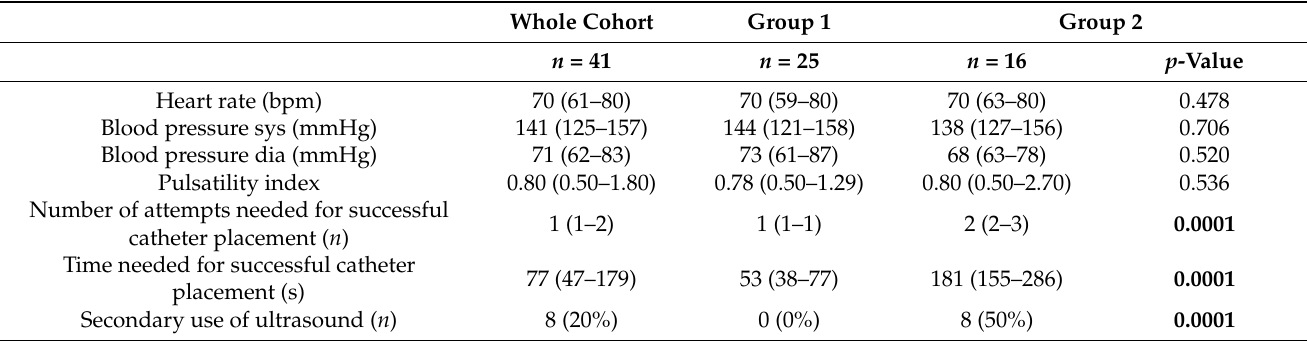
Figure 2. Radial artery catheterization. Time needed for successful radial artery (RA) catheterization with lower body weight, height and surface area as well as with smaller distal (at the level of the styloid process) and 5 cm proximal internal RA diameter. Spearman correlation was used for analysis. Table 2. Results of radial artery cannulation observations in the whole cohort as well as in group 1 (uncomplicated catheterization) and group 2 (difficult catheterization).